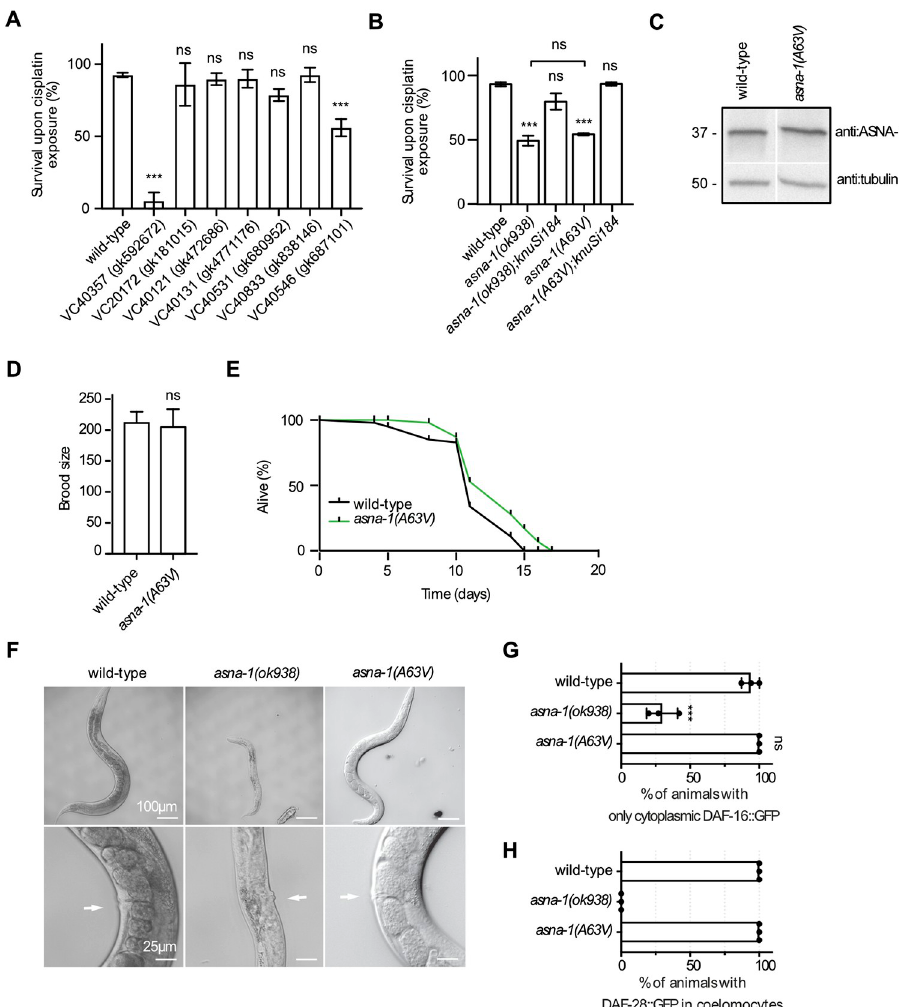
Fig 5. Analysis of ASNA-1 point mutants reveals the importance of a conserved alanine for cisplatin resistance. (A) Analysis of cisplatin sensitivity phenotype of seven million mutation project strains bearing point mutations in asna-1 . (B) Rescue of the cisplatin sensitivity phenotype of asna-1(ok938) deletion mutants and asna-1(gk592672 /A63V) mutants with a single copy ASNA-1(+) transgene knuSi184 . Bars represent mean survival ± SD of 1-day-old adult animals exposed to 300 μ g/mL of cisplatin for 24h. Statistical significance was determined by the one-way ANOVA followed by Bonferroni post-hoc correction. Survival experiments were performed in triplicate. (C) Western blot analysis to estimate ASNA-1 levels in wild-type and asna-1(A63V) mutants. The blot was probed with an anti- ASNA-1 antibody. Tubulin was used as a loading control. For a full uncropped western blot image, see S9 Fig. (D) Brood size analysis of wild-type and asna-1(A63V) mutants (n = 5). Statistical significance was determined by the independent two-sample t-test. Bars represent mean ± SD. (E) Life span analysis of wild-type (n = 40) and asna-1 (A63V) (n = 40) animals. (F) Top panel shows representative DIC pictures of adults to show the body size of wild type, asna-1(ok938) , and asna-1(A63V) strains. The magnification of the germline of the animals is shown in the bottom panel. White arrows indicate the vulva position for orientation purposes. (G-H) Percentage of 1-day-old adults with indicated genotypes displaying (G) only cytoplasmic localized DAF-16::GFP and (H) percentage of 1-day-old adults with secreted DAF-28::GFP in coelomocytes. Experiments were performed in triplicate. Bars represent mean ± SD. (G) Statistical significance was determined by the one-way ANOVA followed by Bonferroni post-hoc correction. with a normal brood size and life span ( Fig 5D and 5E ), and had properly developed germlines ( Fig 5F ). This characteristic opened up the possibility of separating the cisplatin, TAP inser- tion, and insulin functions of ASNA-1 without compromising on the sterility phenotypes seen